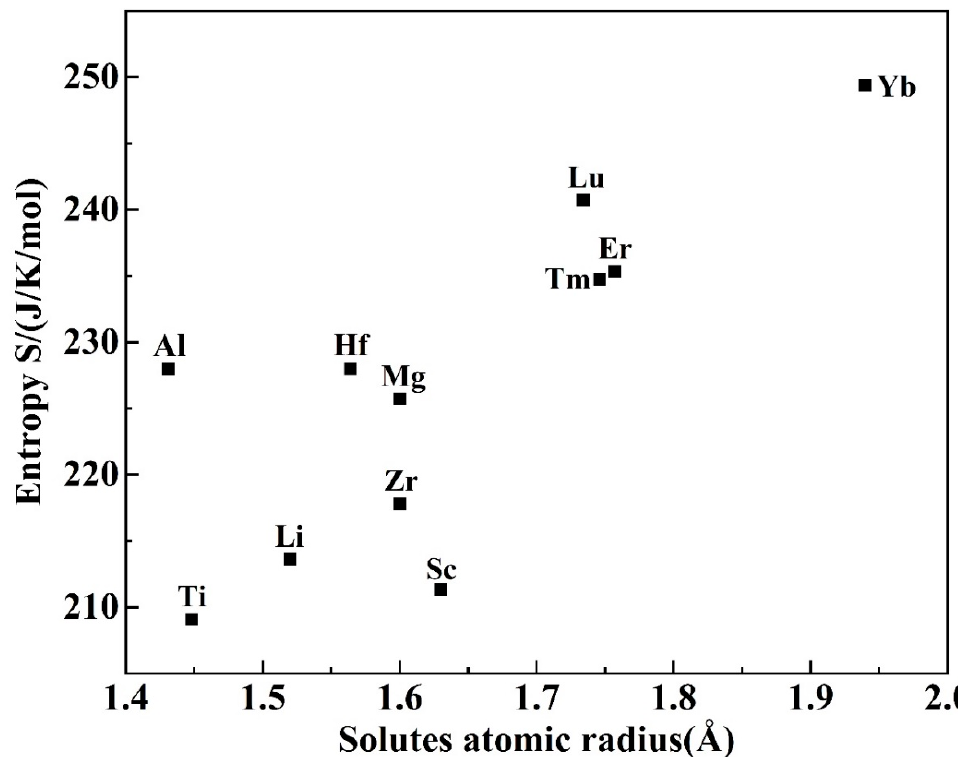
Figure 4. The relationship between entropy and solute atomic (M) radius of Al 3 M at 1000 K.